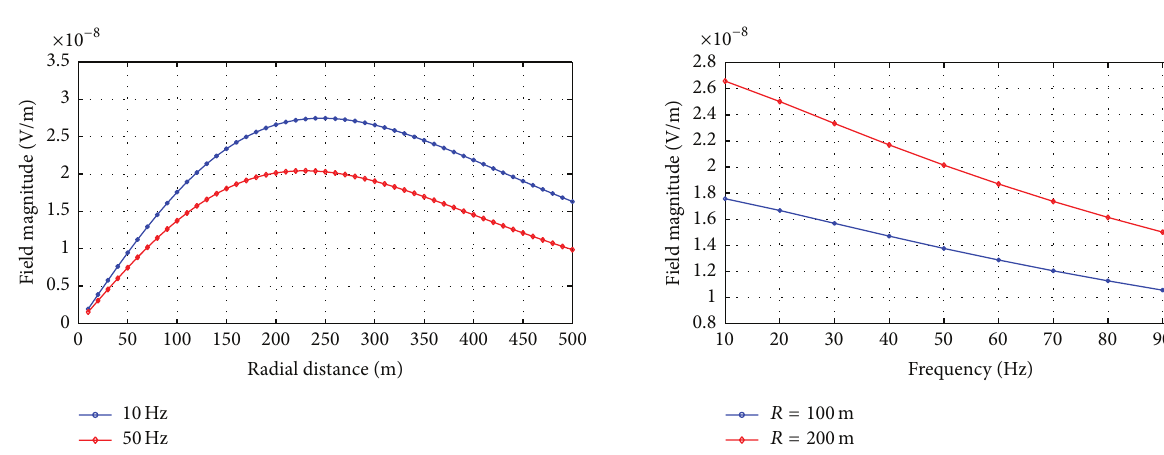
Figure 5: Curves of the total electric field magnitude.